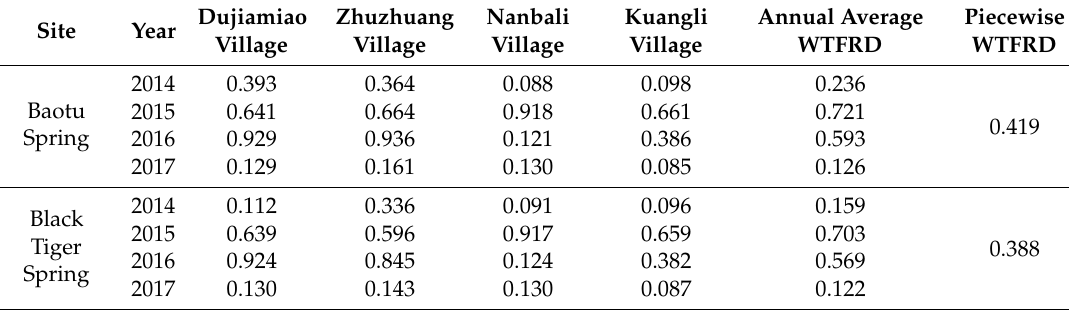
Table 6. WTFRD between Western Jinan and Jinan spring groups from April to July each year. Site